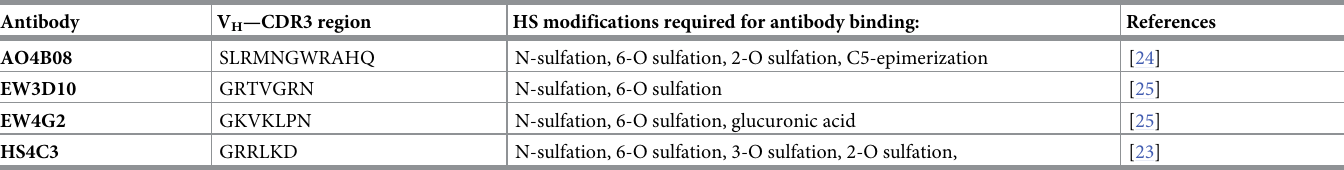
Table 1. Characteristics of HS domains recognized by anti-heparan sulfate (HS) scFv antibodies. Antibody V H —CDR3